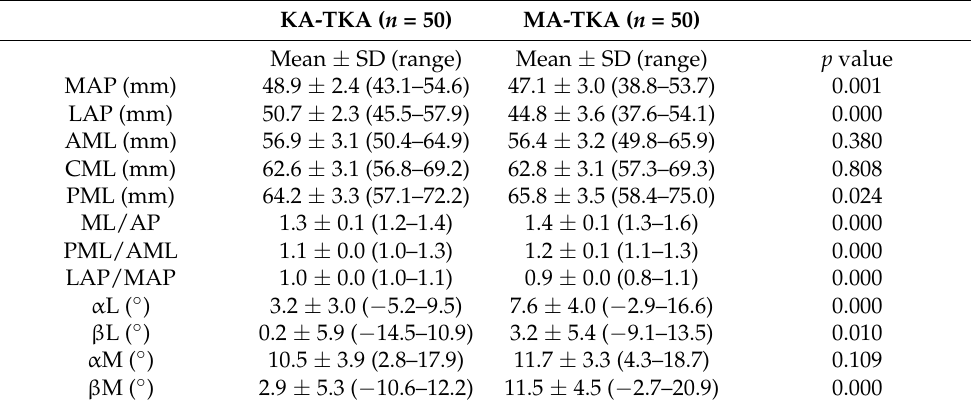
Table 4. Comparison of female distal femoral dimensions by two types of